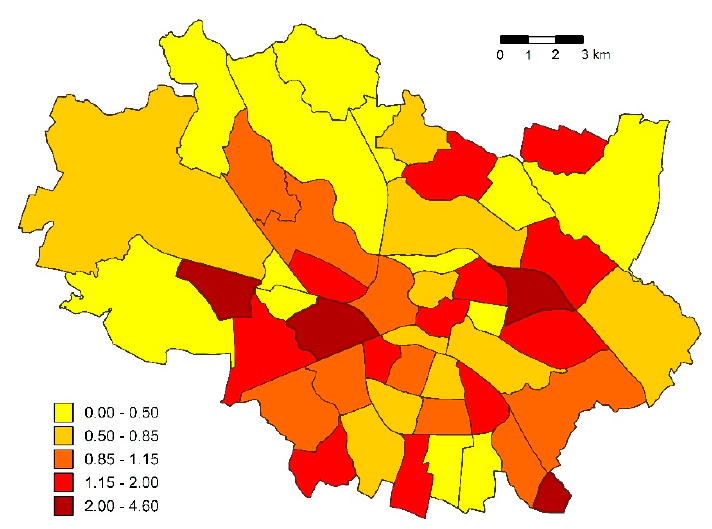
Figure 6. Concentration of high-technology industrial entities in the housing estate of Wrocław in 2016 (sourced by authors).